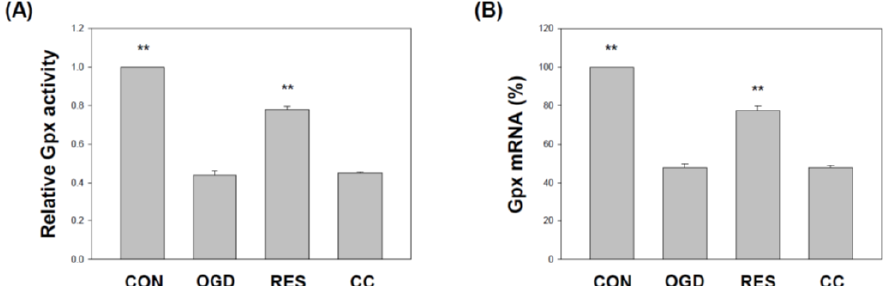
Figure 10. Resveratrol rescues Gpx activity and gene expression by OGD in 3D scaffolds. The cell experiments under the scaffolds were divided into four groups, as described in Figure 1 and the methods section. Gpx activity was detected by the Gpx activity colorimetric method ( A ). ( B ) qPCR was used to analyze the Gpx mRNA level in each treatment group. Values are expressed as percentages of the indicated level in CON and are presented as the mean ± SEM values from three independent experiments. Specific comparison to the indicated SH-SY5Y cells with OGD ** p < 0.001 vs. cells with OGD.